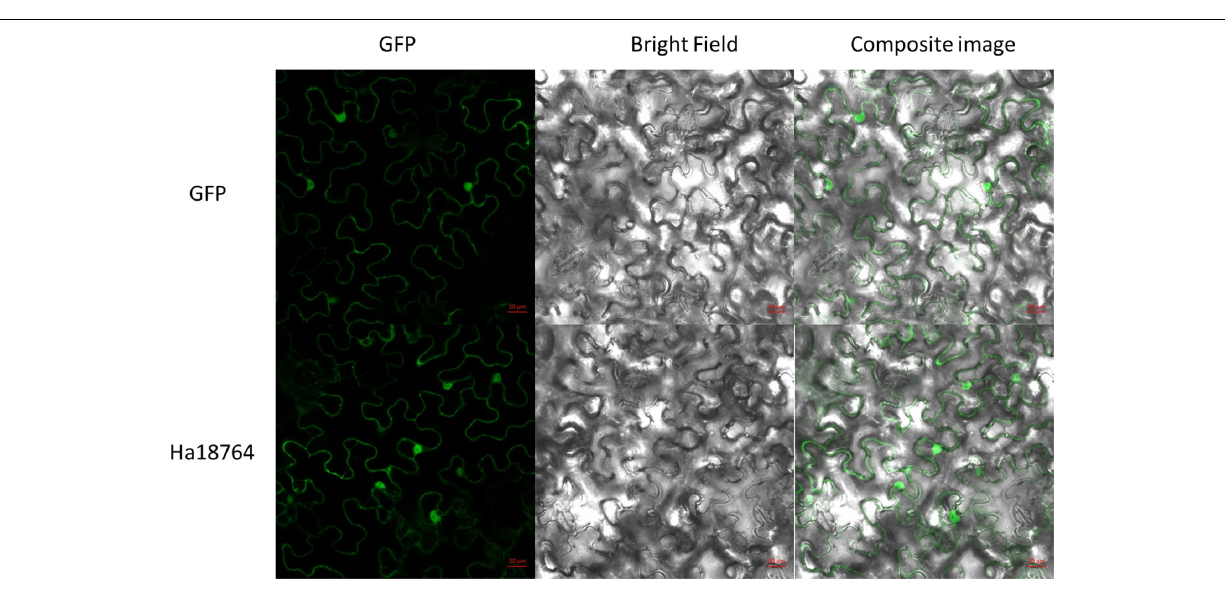
FIGURE 4 | Subcellular localization of Ha18764 in Nicotiana benthamiana leaves. Agrobacterium tumefaciens cells carrying the Ha18764:GFP fusion contrast were infiltrated into N. benthamiana leaves with pCamv35S: GFP used as the control. Scale bar = 20 µ